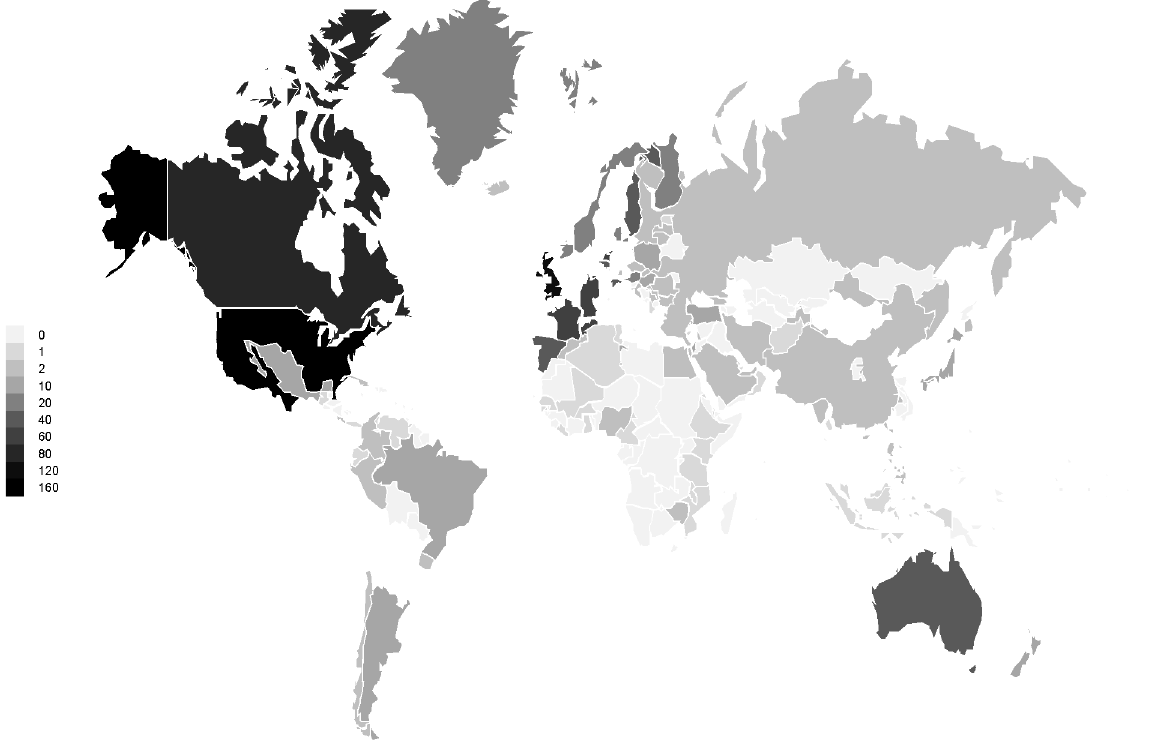
Fig 3. Number of COS studies that have included participants from each individual country throughout the world.